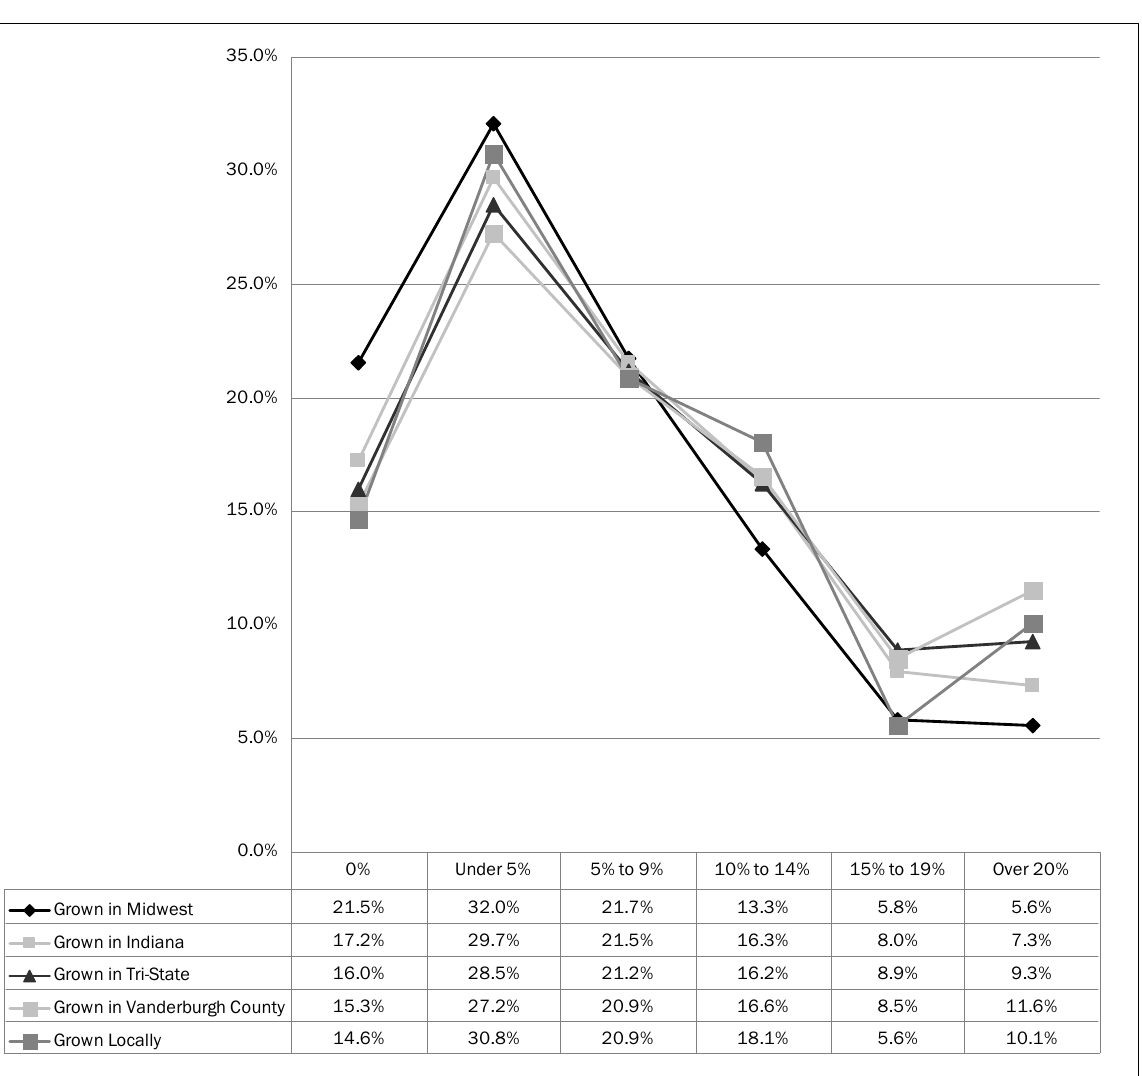
Figure 2. Willingness To Pay